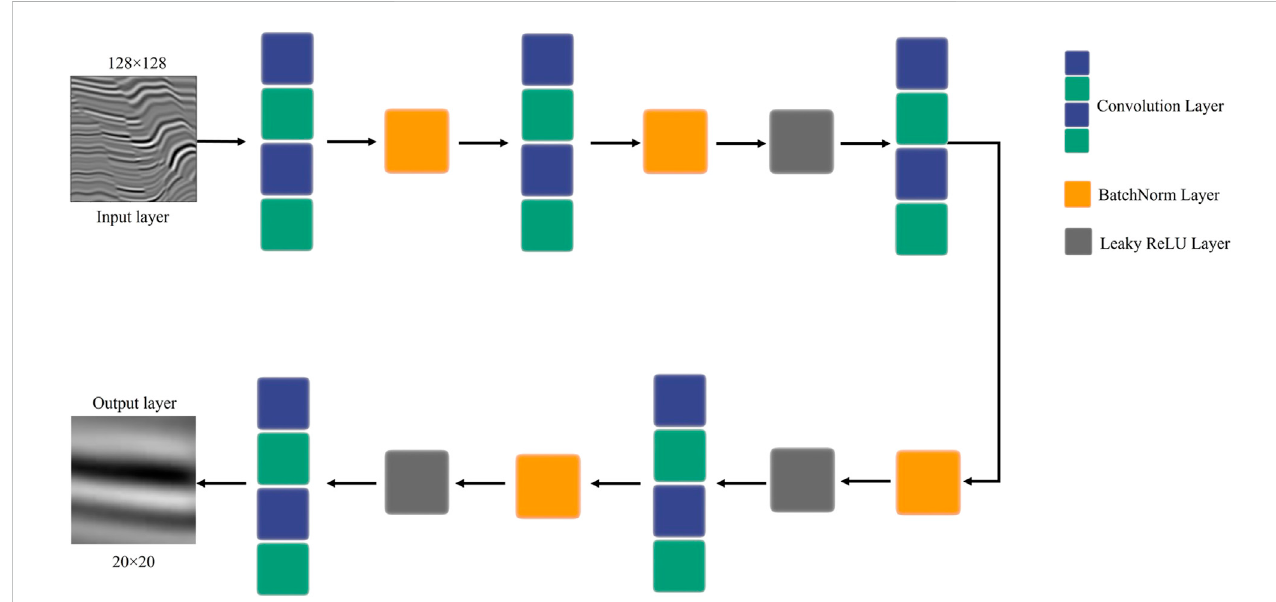
FIGURE 4 Improved CycleGAN discriminator network structure used in this study.